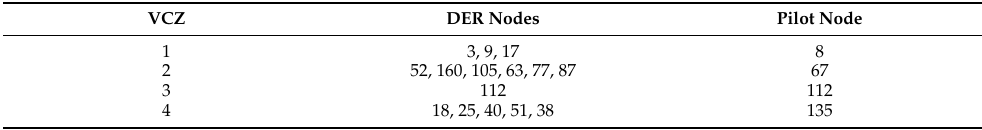
Figure 6. The partition of the IEEE 123-bus system in 7VCZs. Table 4. PNs and DERs nodes in the 4-VCZ